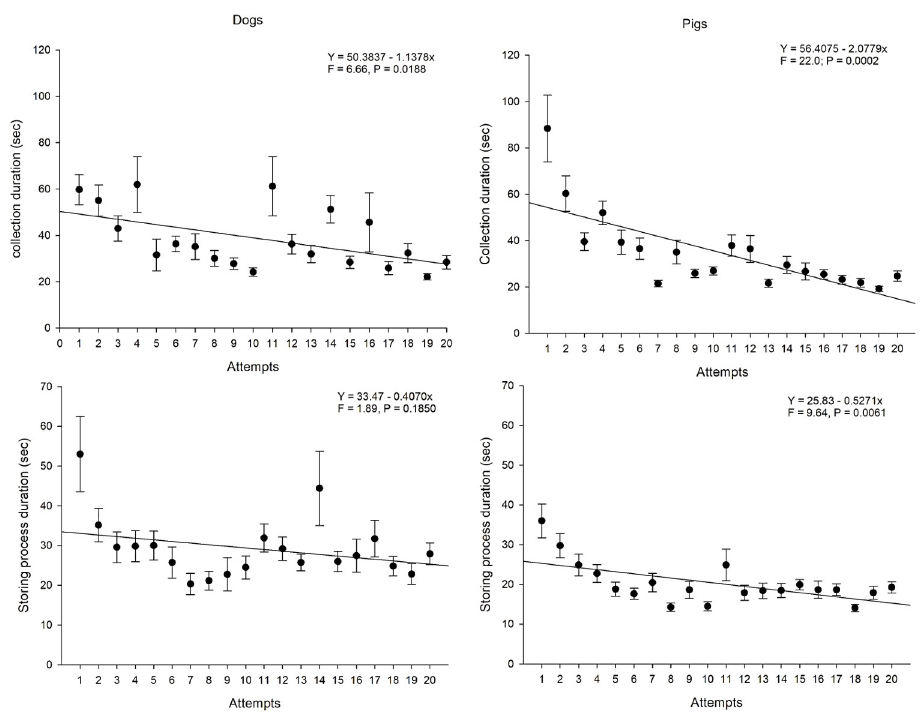
Fig 4. Mean times (seconds) spent in the laparoscopically guided kidney biopsy (duration of collection and storing process) throughout the attempts of the operators in both species (canine and swine). (A) Mean collection duration throughout the study from dogs; B) Mean collection duration throughout the study from pigs. (C) Mean storing process duration throughout the study from dogs. (D) Mean storing process duration throughout the study from pigs. The Y, F, and P values are indicated in each evaluation and show the presence (or not) of statistical differences of the variables considered for this figure among the attempts and between species.